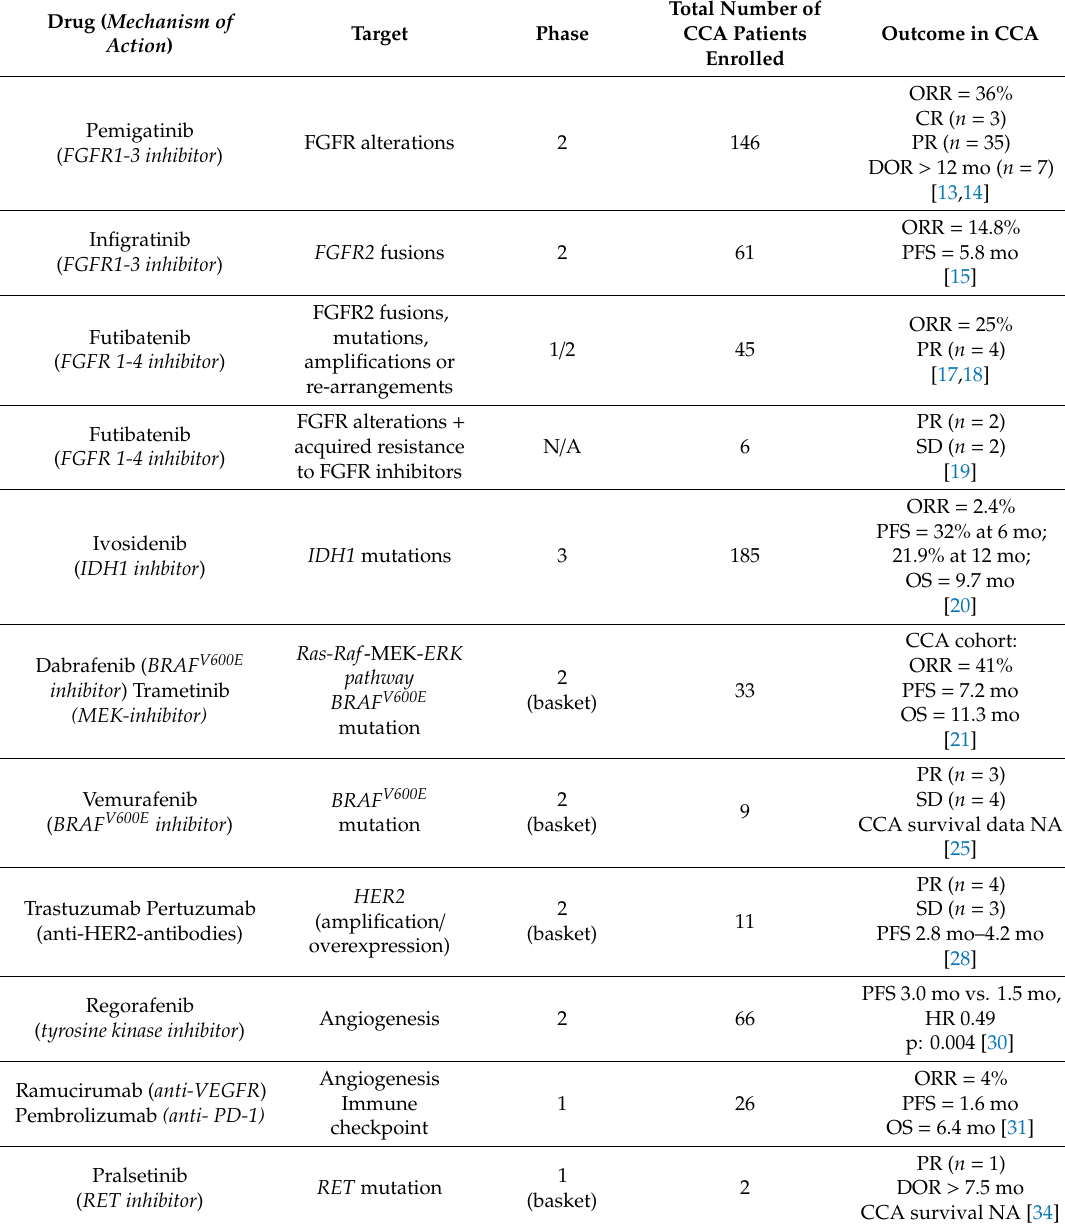
Table A1. Completed clinical trials using targeted / combination therapies in patients with CCAs. NA: not